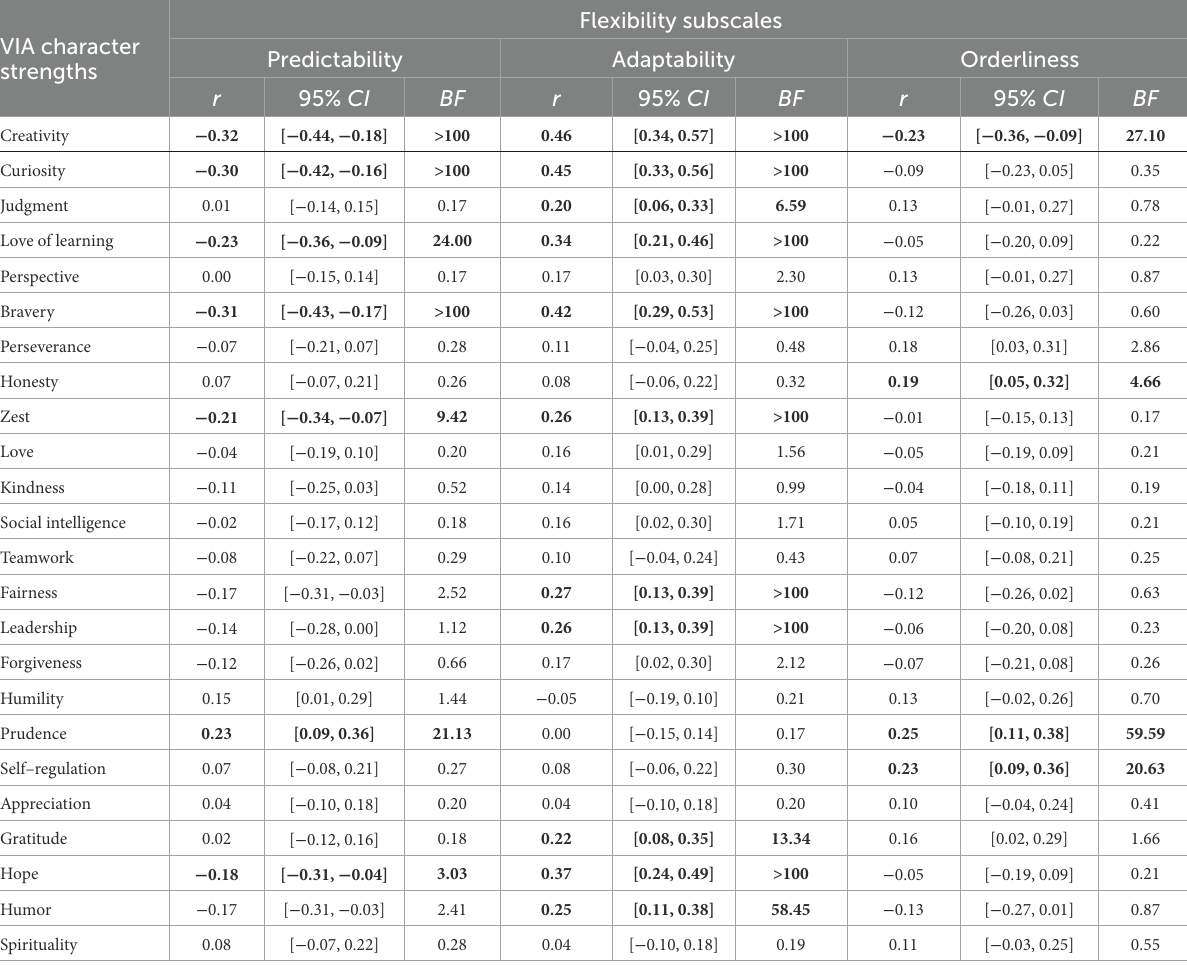
TABLE 2 Study 2: Pearson correlations between flexibility and VIA character strengths (pretest). Flexibility subscales VIA character Predictability Adaptability strengths